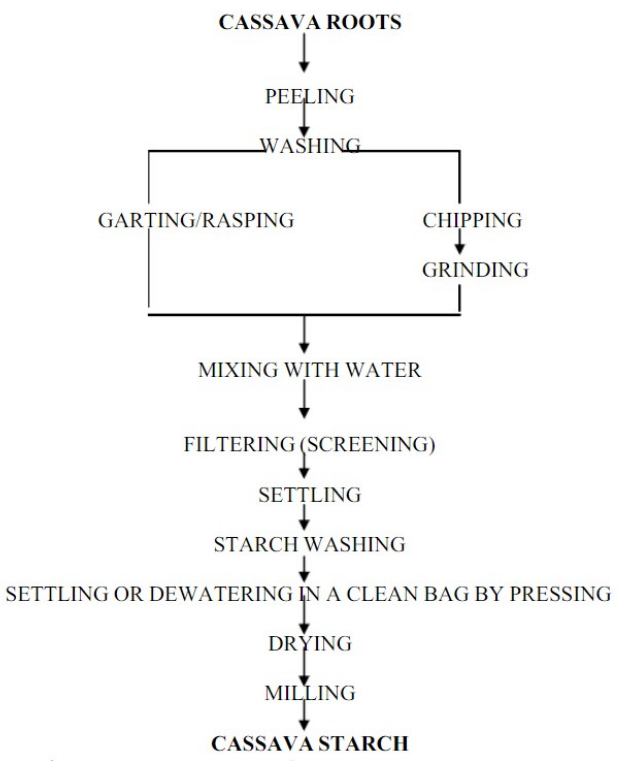
Figure 4. Flow chart for production of cassava starch [119].